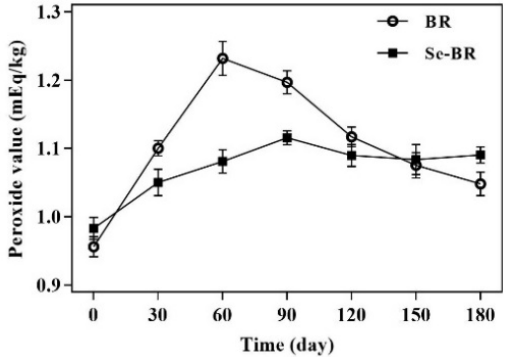
Figure 1. Peroxide value of ordinary brown rice (BR) and selenium-rich brown rice (Se-BR). Each data point is expressed as the mean and standard error of three replicates.